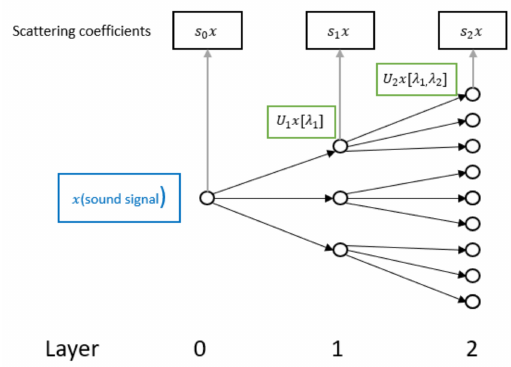
Figure 1. The hierarchical network of wavelet scattering transform.